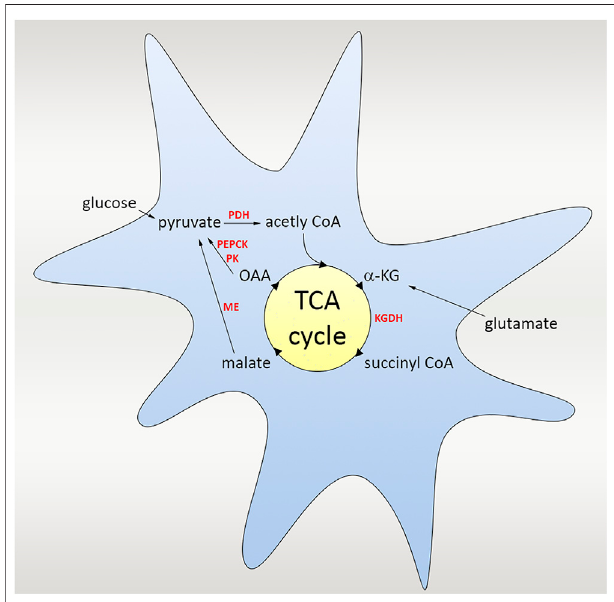
FIGURE 3 | Scheme of the glutamate uptake and the TCA cycle. TCA cycle is a second stage of cellular respiration taking place in mitochondria, in which cells decompose organic molecules in the presence of oxygen and produce energy. The cycle starts with the catalyze of α -ketoglutarate to succinyl CoA via α -ketoglutarate dehydrogenase (KGDH), followed by several steps in the TCA cycle converting the carbon skeleton to malate, which is ultimatelyturnedtopyruvatebymalicenzyme(ME).Asanalternative,pyruvate kinase (PK) and phosphoenolpyruvate carboxykinase (PEPCK) work and convert oxaloacetate (OAA) to pyruvate. Pyruvate dehydrogenase (PDH) also re-enters the TCA cycle, and the carbon skeleton derived from glutamate could be oxidized to CO